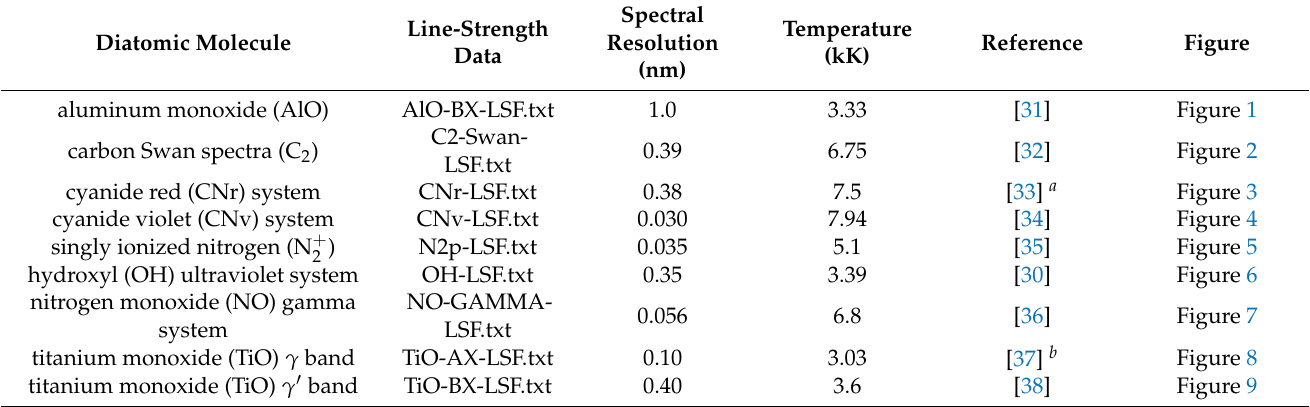
Table 7. Diatomic molecules, spectral resolution, temperature, and one typical reference each that uses the data.